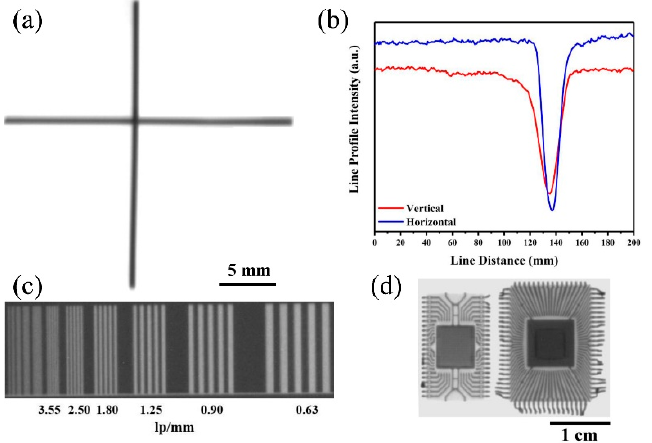
Figure 7. The X-ray dose rate of gated CNTs X-ray source at V a = 45 kV. The energy spectrum was recorded under 50 kV anode voltage by the Cd-Te X-ray energy spectrum detector, as shown in Figure 8. The two peaks at 17.48 and 19.58 keV in the X-ray spectrum correspond to characteristic emissions of the K-shell of the Mo target [48]. were also clearly imaged as shown in Figure 9d.